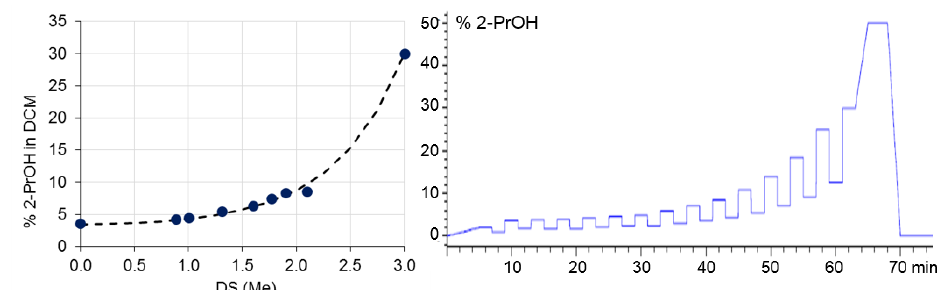
Figure 7. Correlation of DS and 2-PrOH (vol %) at the peak midpoint of MC-MeOBz according to their average DS ( left ); eluent program with stepwise enhancement and decrease of the ratio of 2-PrOH in DCM ( right ).